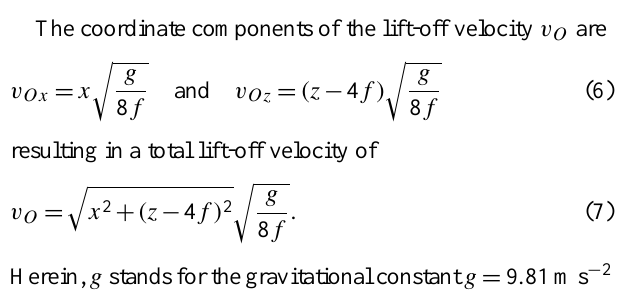
Fig. 9. Lift-off and impact velocity for an assumed jump height of f/s = 1/8 as a tool for rapid trajectory analyses in the field. As an example, the series of measured values (see Fig.